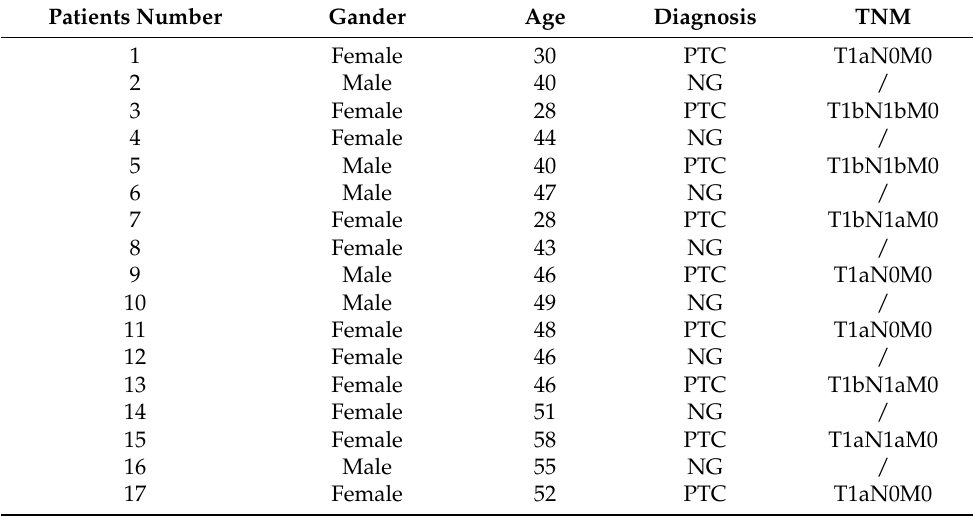
Table 2. The information of 16 papillary thyroid carcinoma (PTC) and 16 nodular goiter (NG)